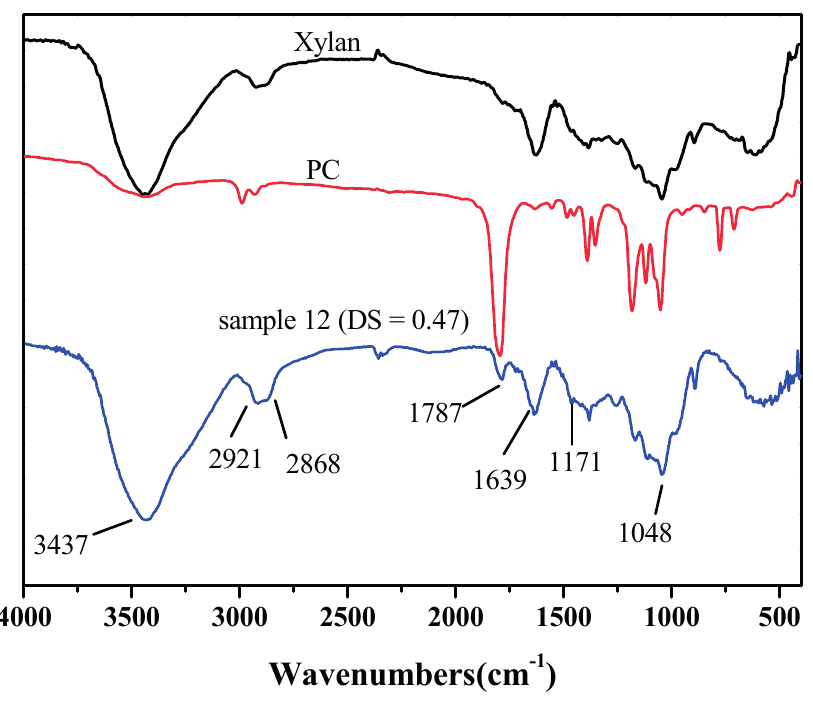
Figure 1. FT-IR spectra of unmodified xylan, pure PC and xylan- g -PPC copolymer sample 12 (DS =